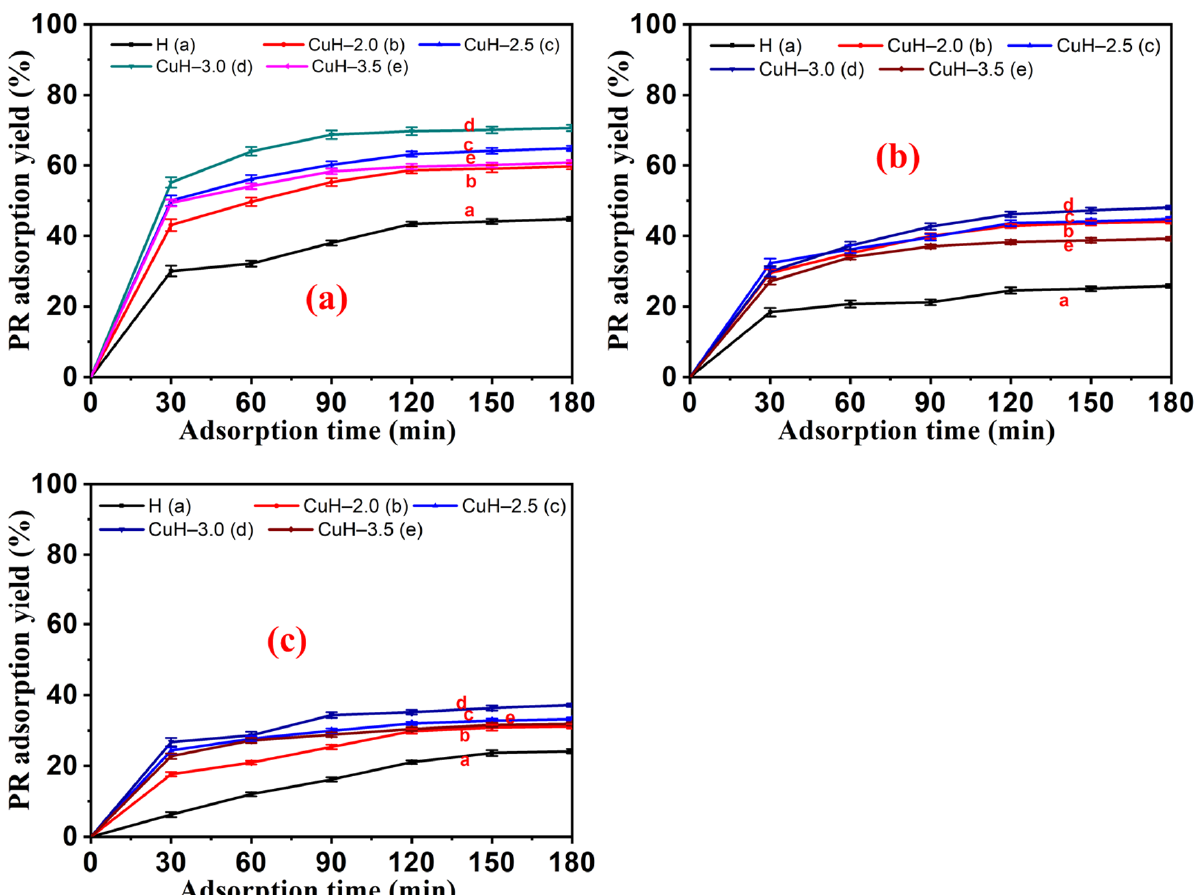
Figure 7. PR adsorption capacity at concentrations of 50 ppm ( a ), 75 ppm ( b ), and 100 ppm ( c ) on hydrotalcite samples.